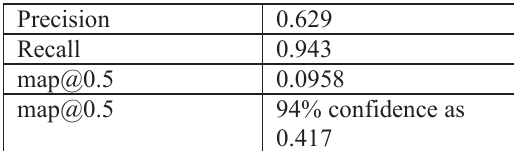
Table 1. Training results of proposed system